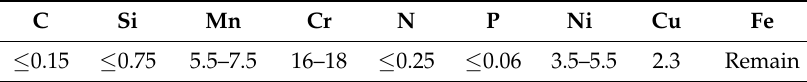
Table 1. Chemical composition (wt %) of 201 stainless